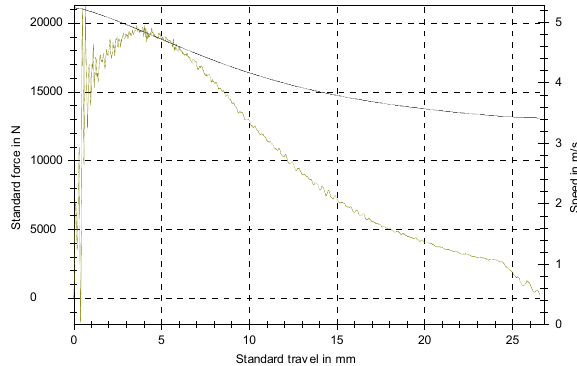
Figure 4. Force-displacement diagram.